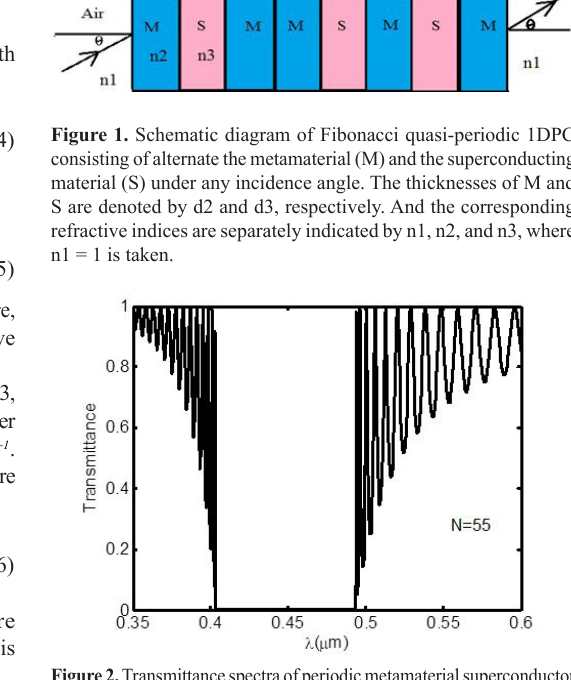
Figure 2. Transmittance spectra of periodic metamaterial superconductor photonic crystal for N=55 periods.